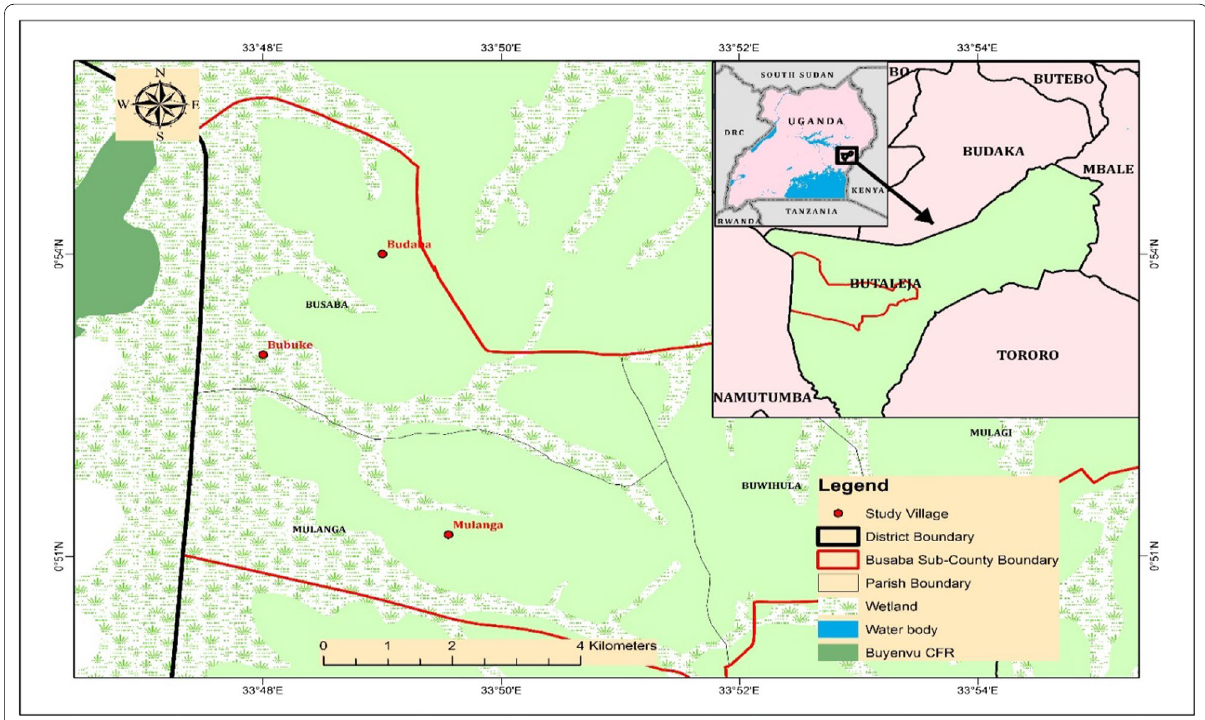
Fig. 1 Location of the study